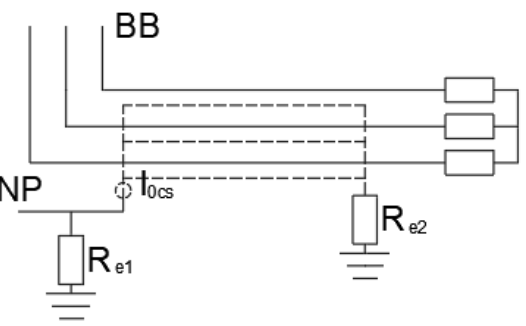
Figure 3. Measuring system; NP —neutral point of ZNyn transformer, BB —MV busbars, R e 1 —resistance of 110/15 earthing system; R e 2 —resistance of MV earthing system.